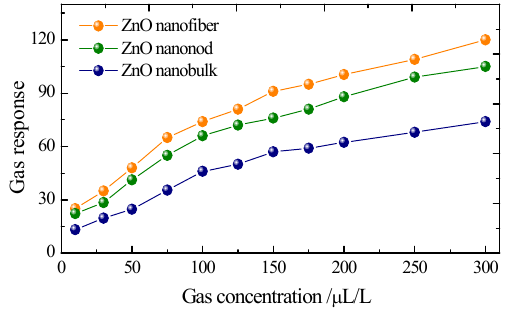
Figure 6. The response-recovery curves of the sensors to 100 µL/L of CH